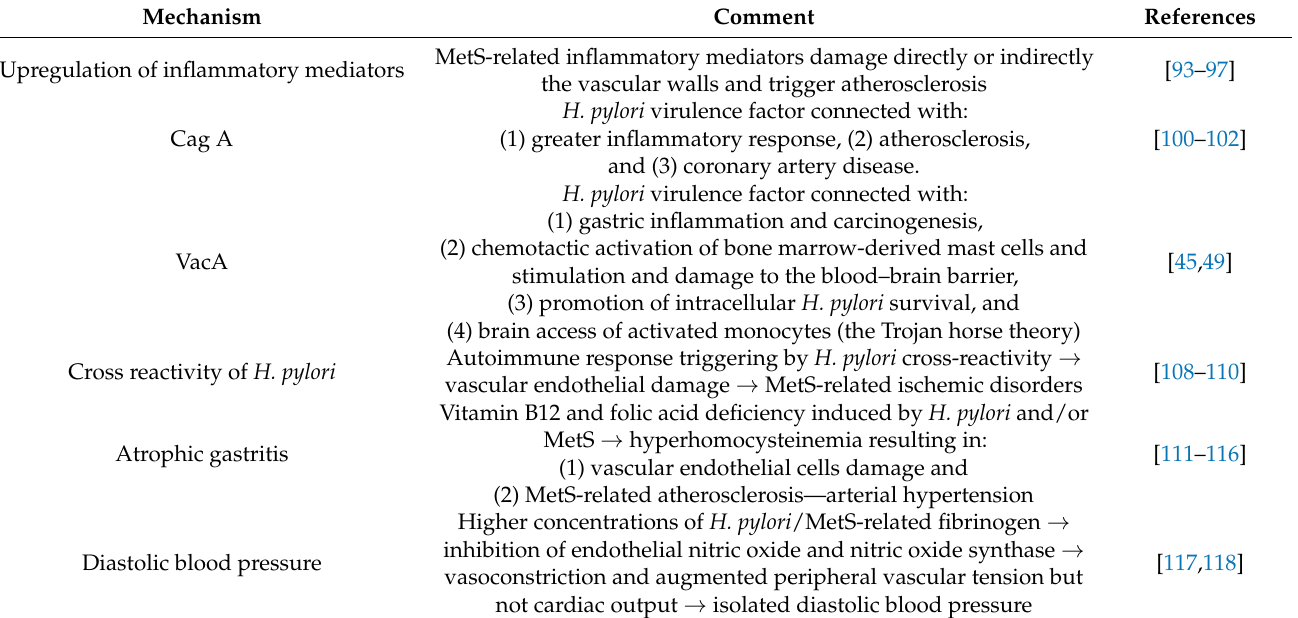
Table 2. Proposed pathogenetic mechanisms of H. pylori and MetS-induced inflammation on arterial hypertension.